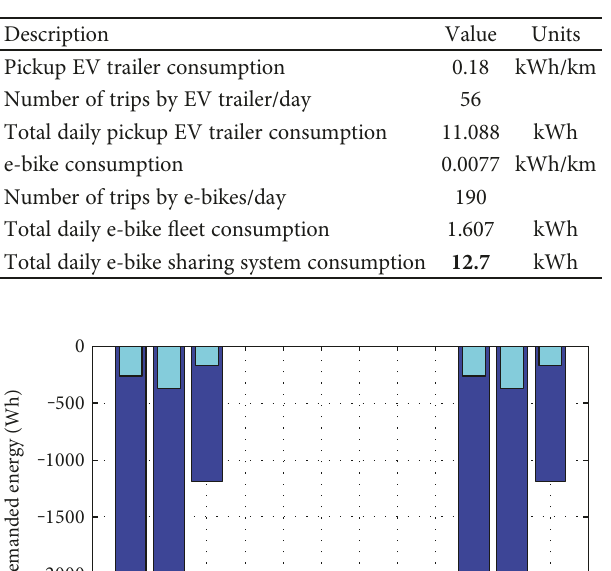
Table 7: Energy demanded by the proposed e-bike sharing system (e-bikes plus pick up EV trailer).